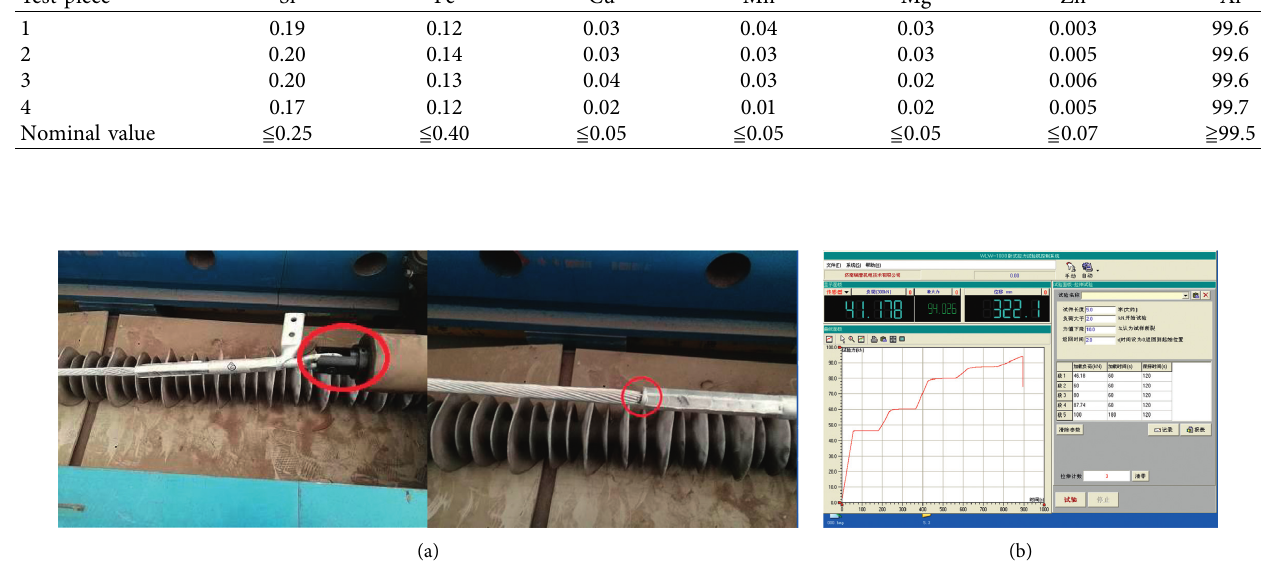
Figure 12: Stretching test for the strain clamp-conductor system: (a) gripping device for the strain clamp and the breaking position of the wire; (b) load data for test piece 1 at each step.